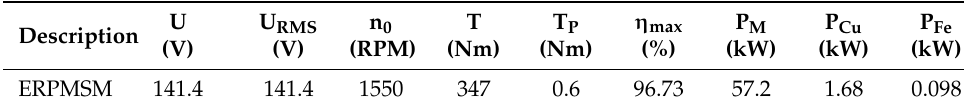
Table 13. Final results of simulation tests obtained for ERPMSM.